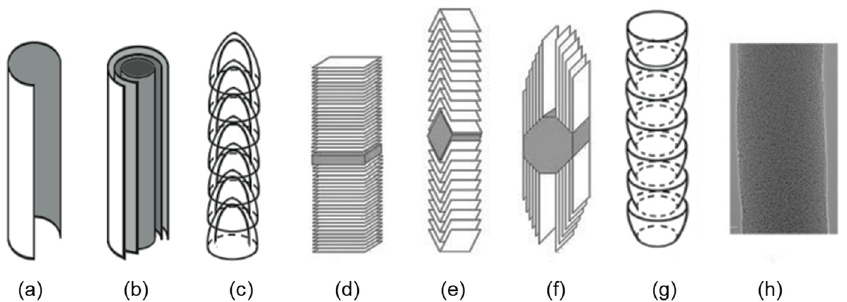
Figure 2. Details of the nanostructure of different types of carbon nanofibers: ( a ) single-walled nanotube; ( b ) multi-walled nanotube; ( c ) bamboo-like nanotube; ( d ) platelet; ( e ) fishbone; ( f ) ribbon; ( g ) stacked cup; ( h ) amorphous [3,4].